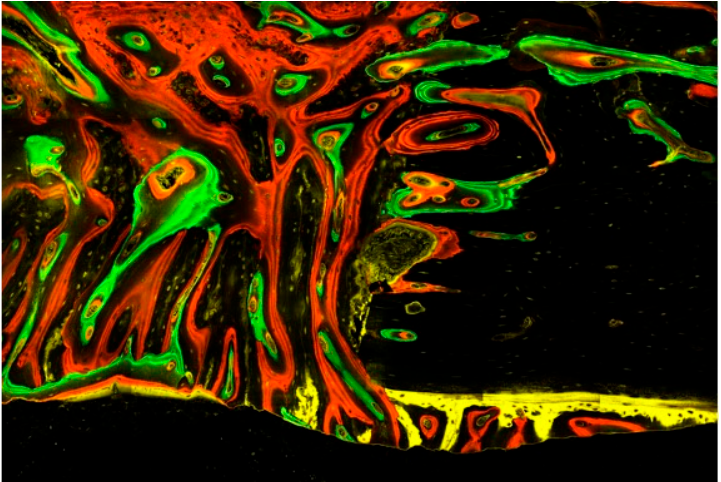
Figure 6. This image illustrates the different episodes of bone tissue formation documented by the four fluorescent dyes: the initial tissues are gradually replaced by connective tissue, including a multitude of mesenchymal cells and osteoblasts embedded in a fibrous matrix prior to mineralization into woven bone and finally lamellar bone with osteocytes. Of particular note are the remodelling processes emanating from the Haversian and Volkmann channels opened in the existing bone as well as the early mineralized tissue appositions underneath the periosteum, having been taken off during surgery. Evaluation with a confocal laser microscope (Zeiss Laser Scanning Microscope LSM 800) scanning fluorescent samples at ×40 magnification.